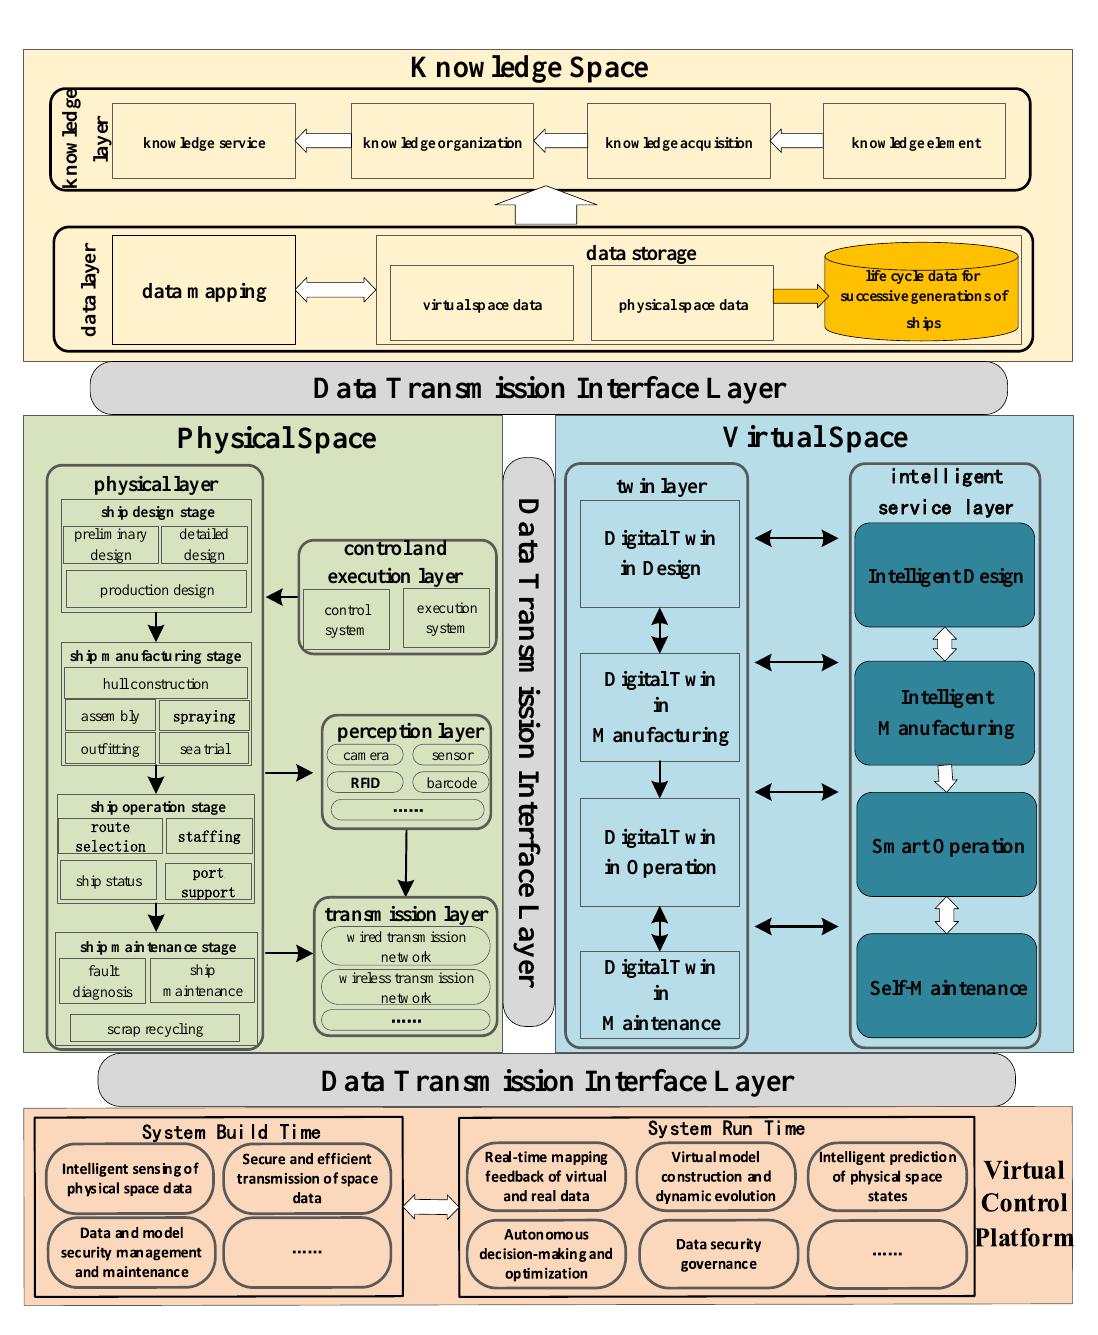
Figure 2. The architecture of SWLC-DT.